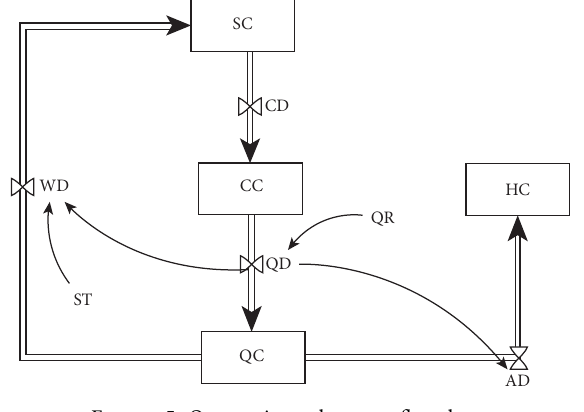
Figure 5: Quarantine subsystem flowchart.